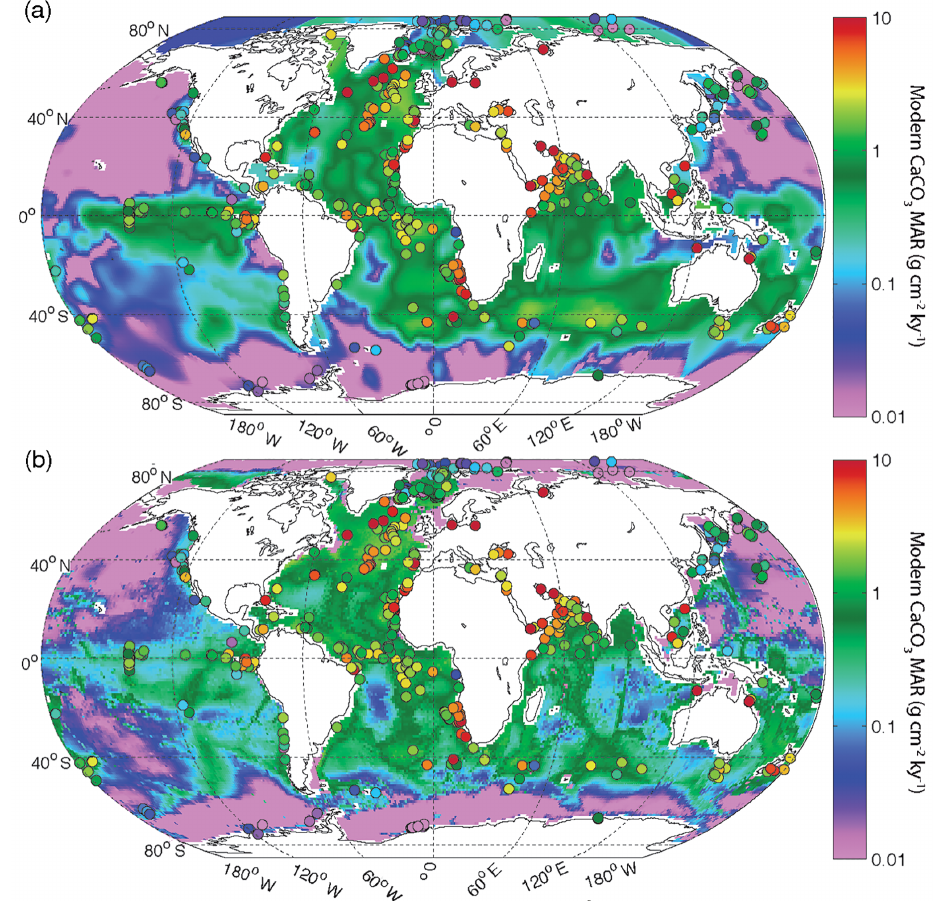
Figure 2. (a) Deep-sea CaCO 3 burial based on sedimentary data; (b) CaCO 3 burial based on a metamodel optimized to fit the sedimentary data (Dunne et al., 2012). Filled circles show Holocene CaCO 3 burial from sediment cores used in the reconstruction of past burial fluxes, using the same color scale. Note that many sediment cores were collected at sites with accumulation rates that exceed the local average sedimentation rate, a common practice to obtain high-temporal-resolution records for paleoceanographic studies (see Sects. A1 and A4 in the